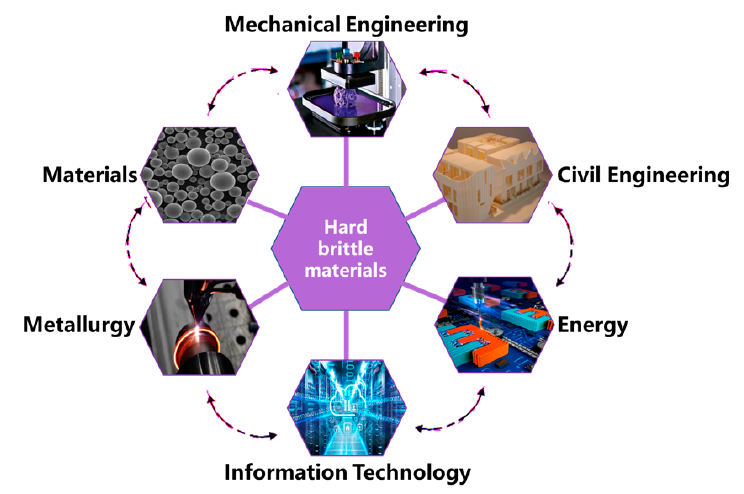
Figure 1. Application of hard brittle materials.